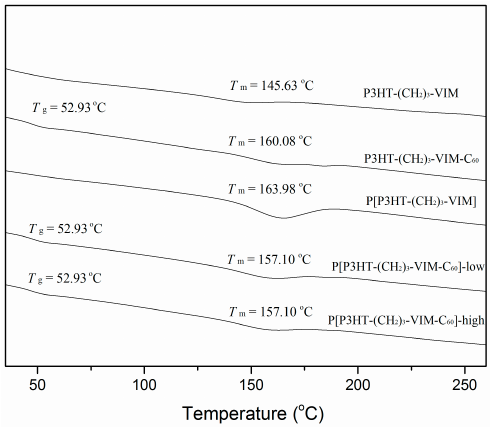
Figure 16. DSC curves showing T g and T m of macromer P3HT-(CH 2 ) 3 -VIM, brush polymer P[P3HT-(CH 2 ) 3 -VIM], and their C 60 adducts.